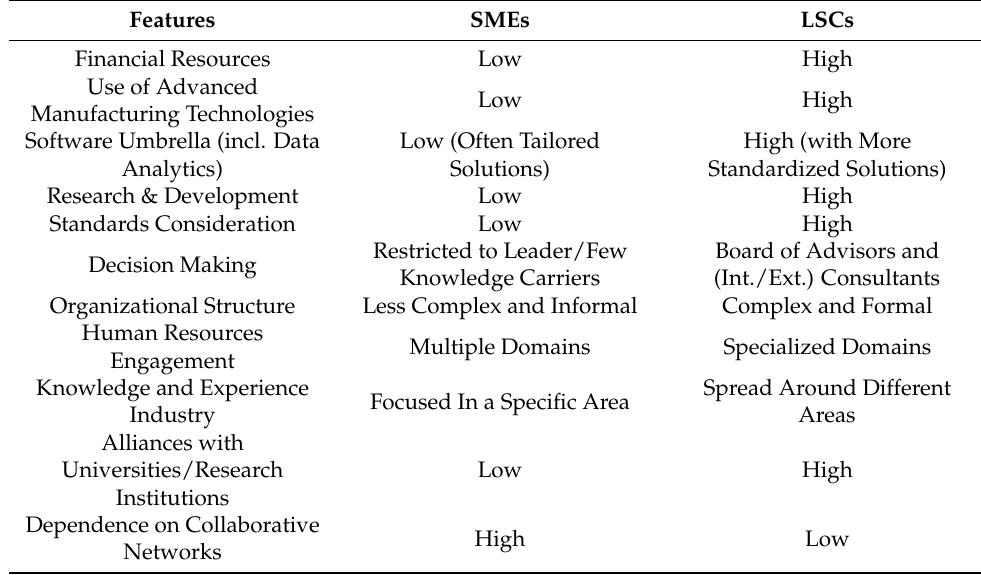
Table 2. Comparison of the SME and LSC (own work, based on [45]).